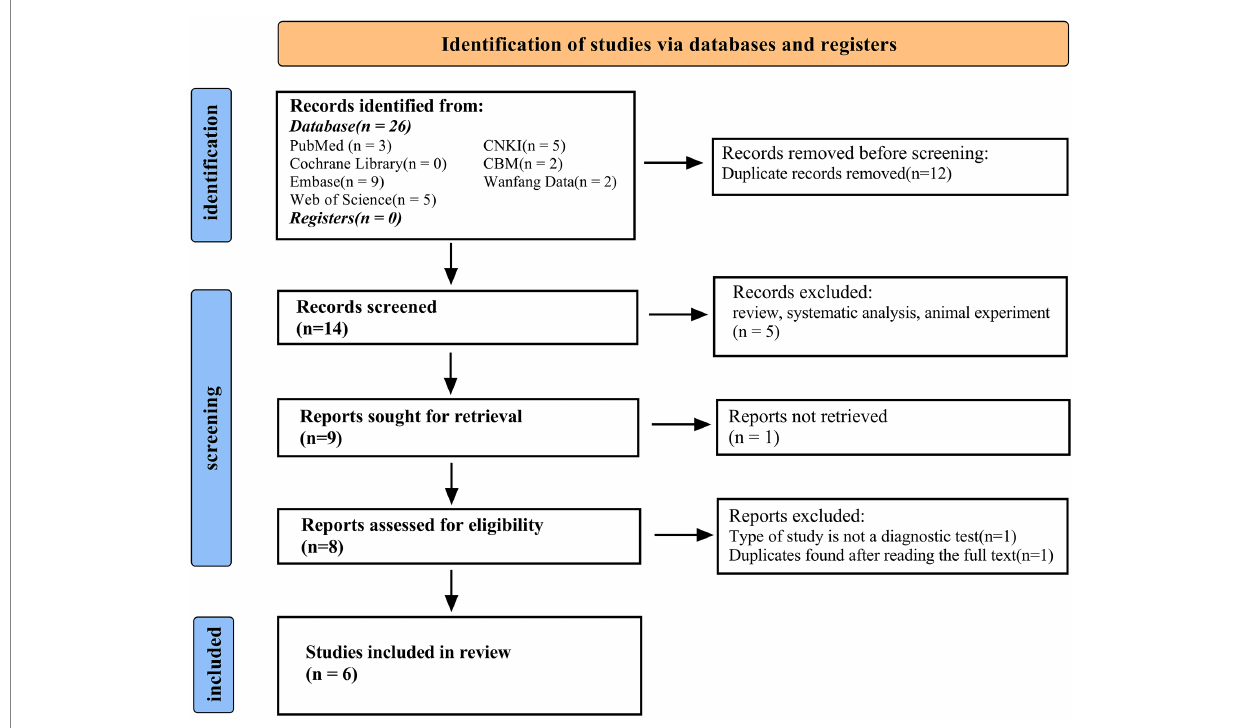
FIGURE 1 PRISMA (preferred reporting items for systematic reviews and meta-analyses) flow diagram and exclusion criteria.